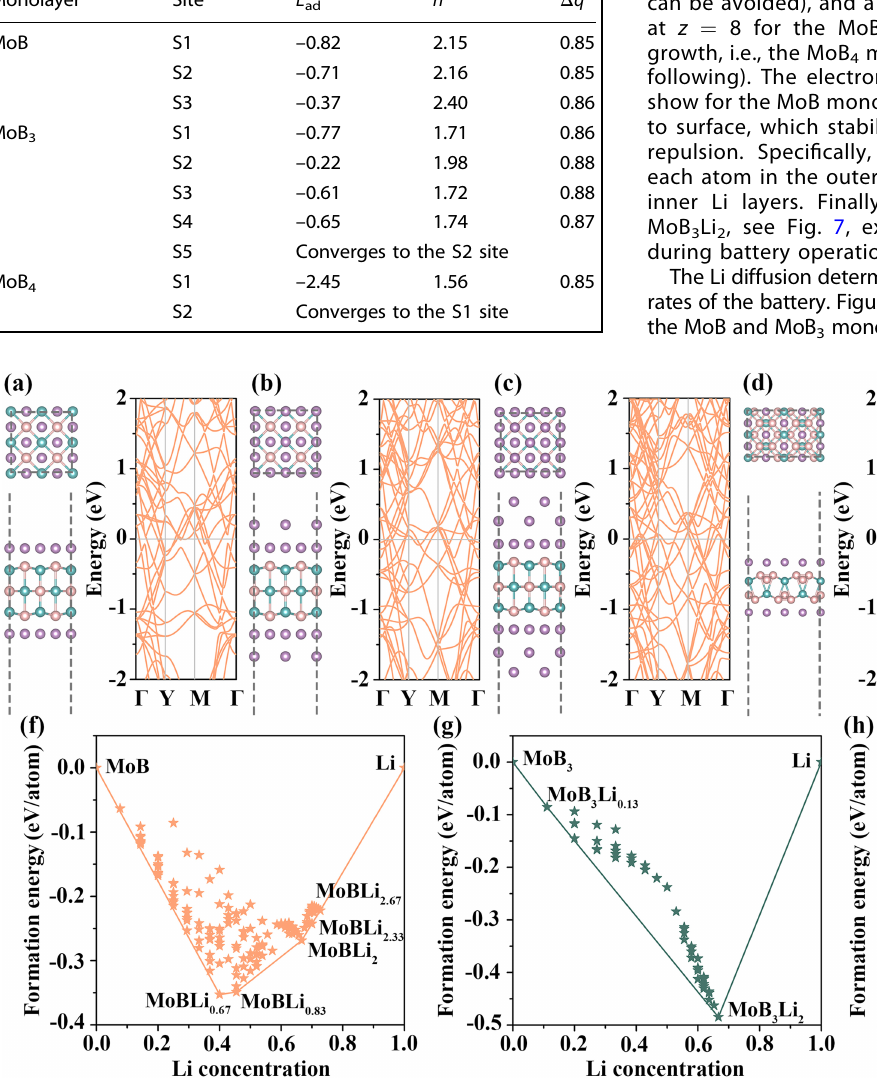
Fig. 5 Li adsorption. Top and side views as well as electronic band structures of the MoB monolayer with a one, b two, and c three layers of adsorbed Li atoms and d of the MoB 3 monolayer with one layer of adsorbed Li atoms, and e of the MoB 4 monolayer with one layer of adsorbed Li atoms. f – h Formation energy per atom of MoB x Li m ( x = 1, 3, and 4) as function of the Li concentration m /( m +